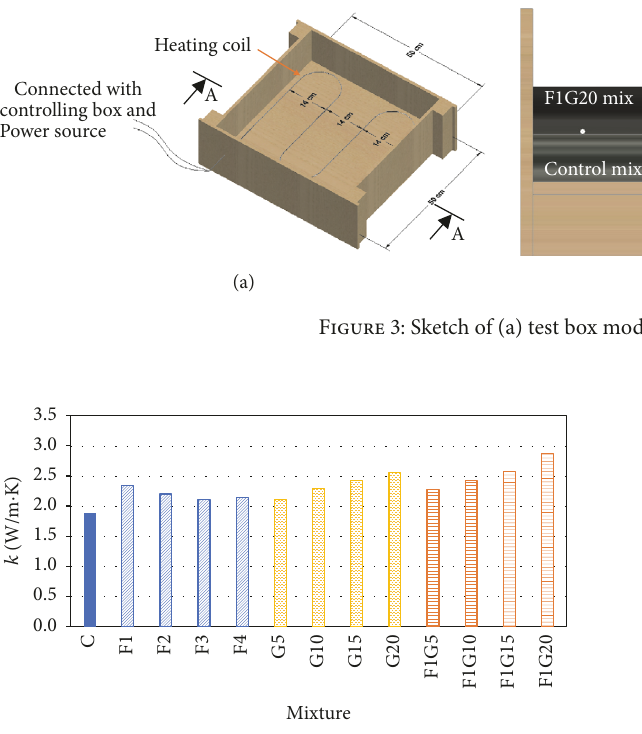
Figure 4: Average thermal conductivity result.